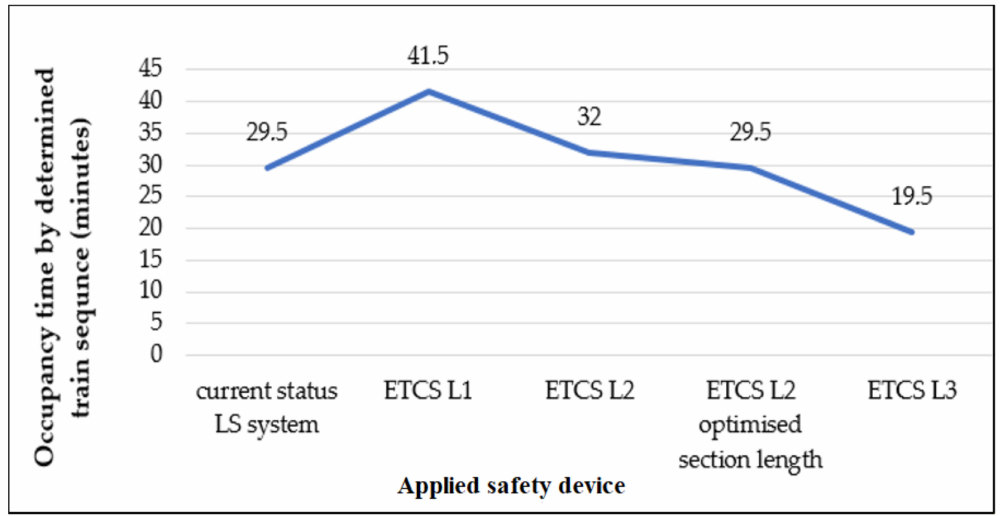
Figure 12. Mutual comparison of the resulting occupancy